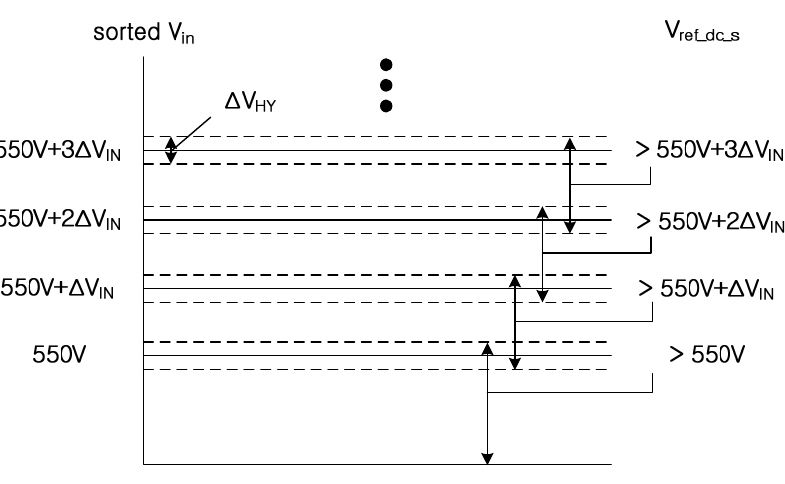
Figure 10. Range setting of the variable DC-link